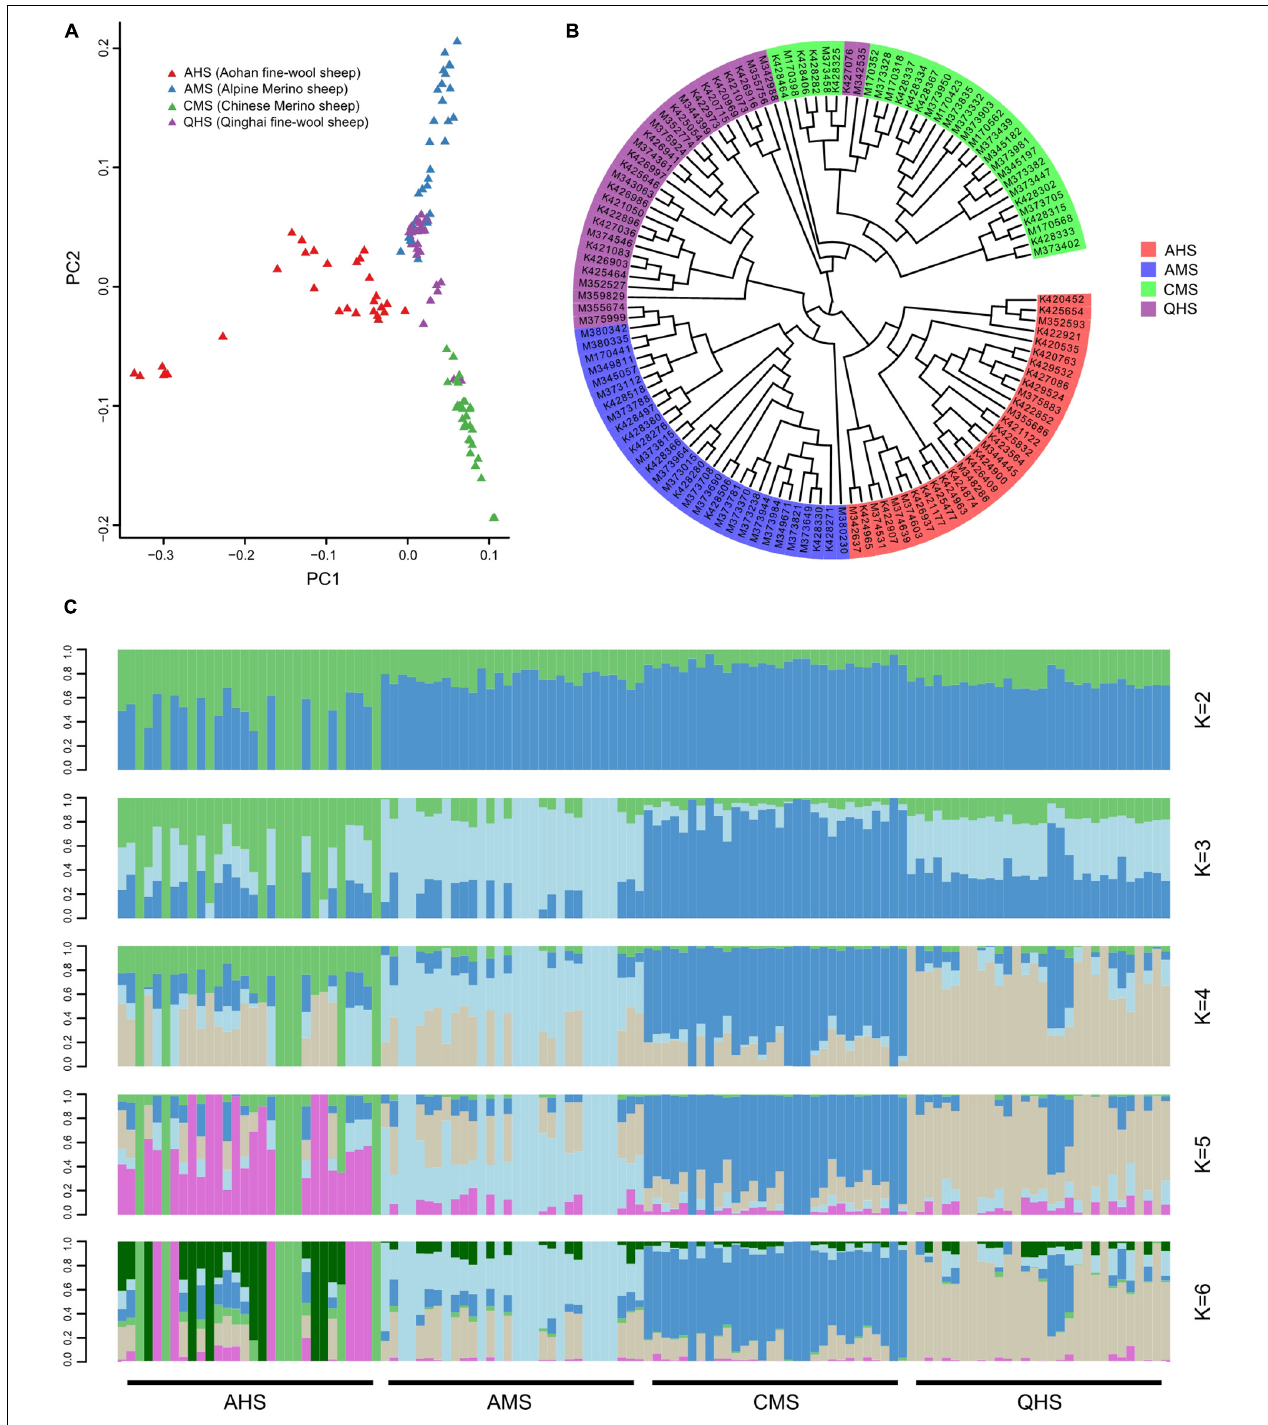
FIGURE 1 | Population genetics structure. (A) Principal component analysis of identified SNPs. (B) Neighbor-joining (NJ) tree. (C) Genome-wide admixture analysis inferred from SNPs.